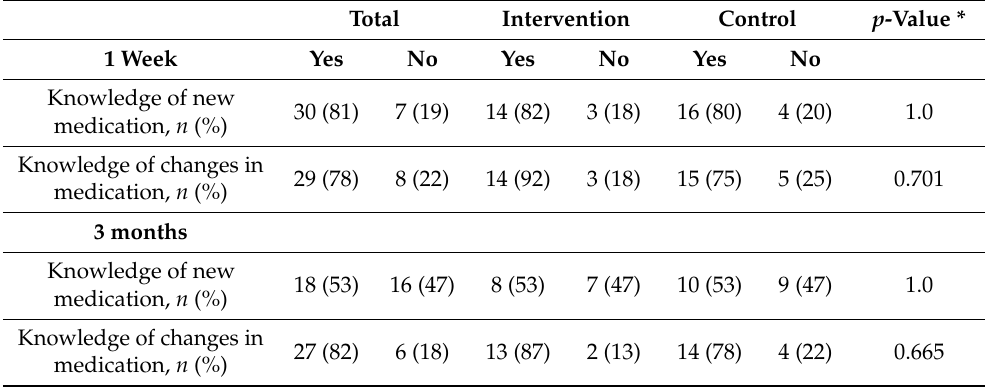
Table 3. Comparison between intervention group and control group for verified knowledge of new medications or changes in medication at 1 week and 3 months. Total Intervention Control p -Value *